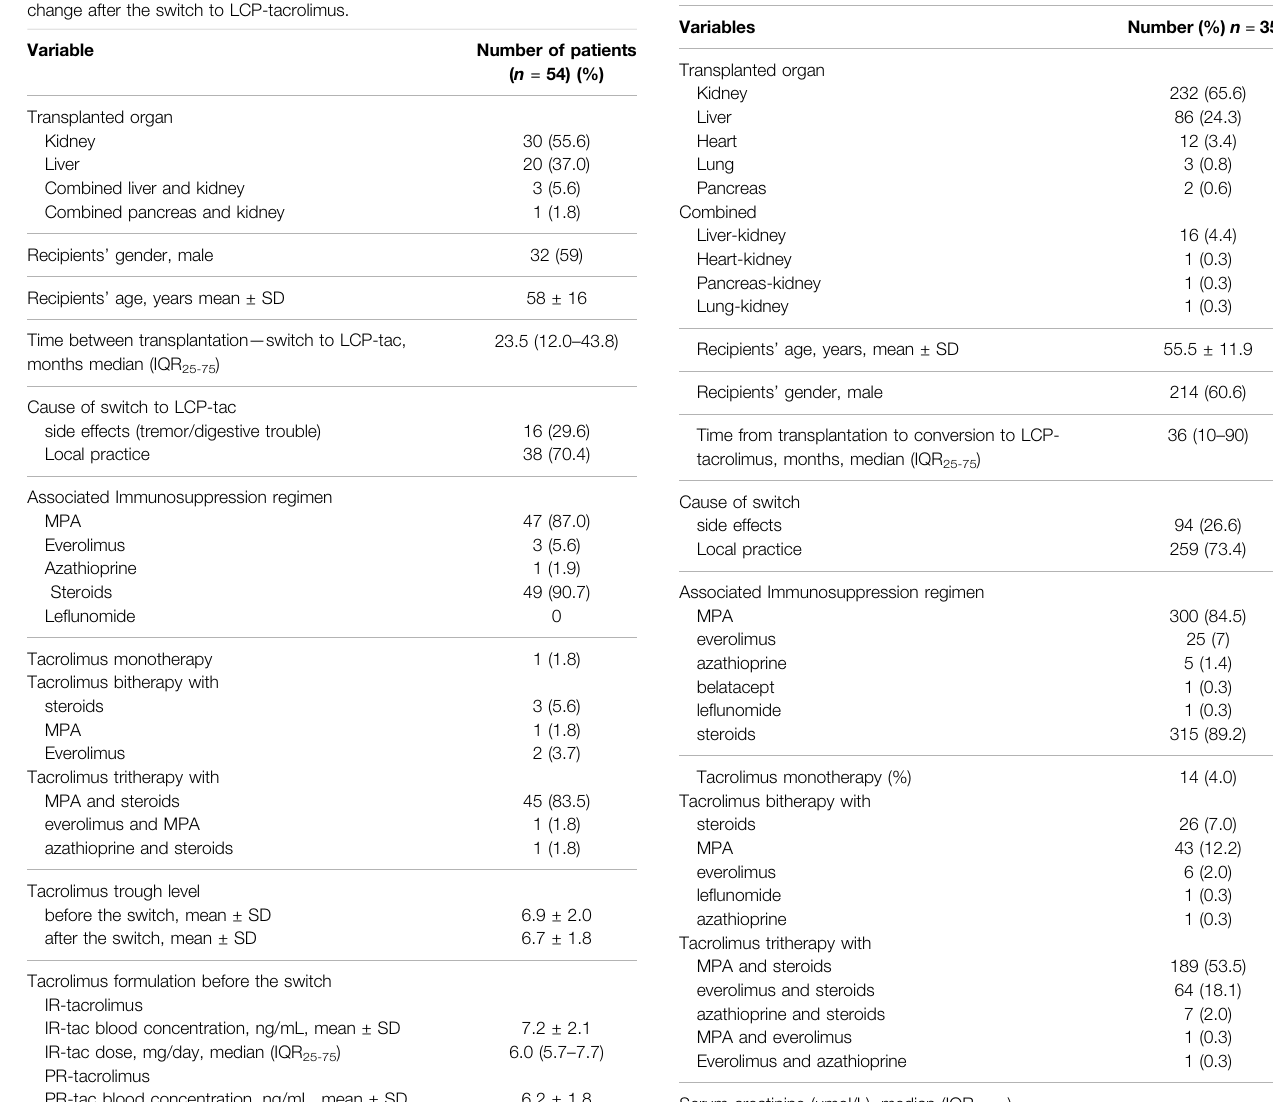
TABLE 2 | Mains characteristics of the patients converted to